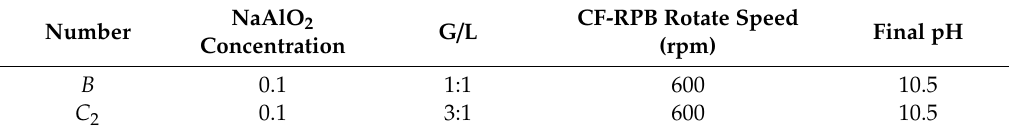
Table 7. The final pH of PB prepared under suitable operating